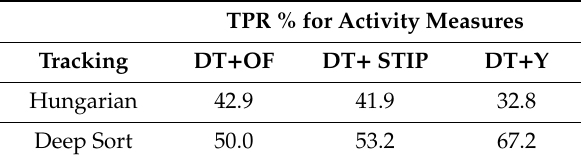
Table 3. True positive rates (TPR %) for active player